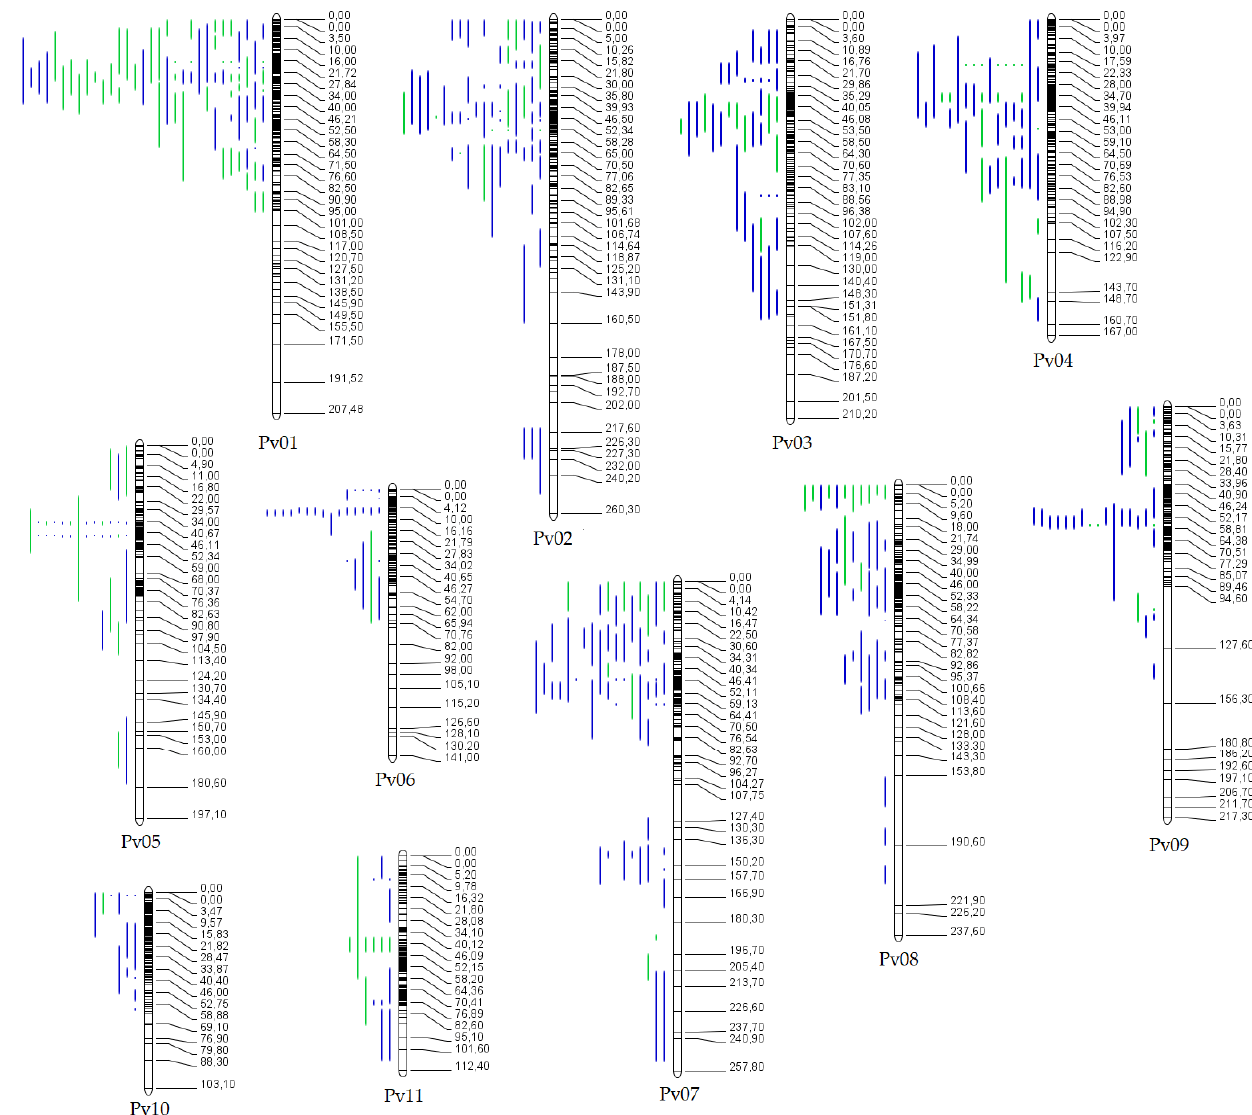
Figure 2. Distribution of the QTL projected throughout all 11 chromosomes (Pv01 to Pv11) on the consensus genetic map. Bars on the left side of the chromosome correspond to QTL related to phe ‐ nological (green bars) and yield ‐ related (blue bars) traits. Black bars within chromosomes represent marker density. The numbers on the right side of the chromosome correspond to the genetic dis ‐ tance in cM.